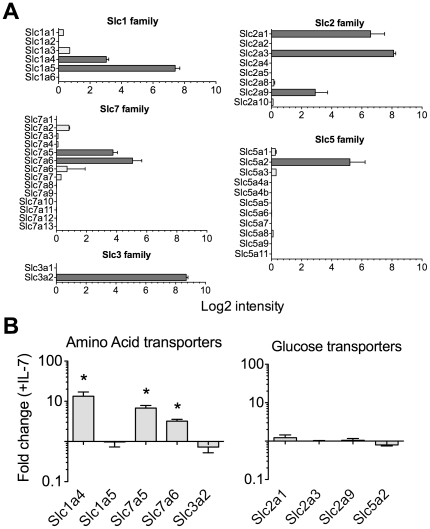
Regulation of amino acid transporter expression by IL-7 signaling.Microarray analysis was performed to compare gene expression in purified CD8+ populations of F5 T cells from F5 Rag1−/− mice ex vivo (n = 4) or following culture with 50 ng/ml IL-7 for 24 h (n = 4) (Pearson et, in press). (A) Graphs show relative expression level of indicated genes in F5 T cells ex vivo. (B) Graphs indicate fold change in expression of those amino acid and glucose transporters expressed in F5 T cells, following culture with IL-7, as compared with expression in ex vivo F5 T cells. Error bars indicate SD of technical replicates. * p<0.05.